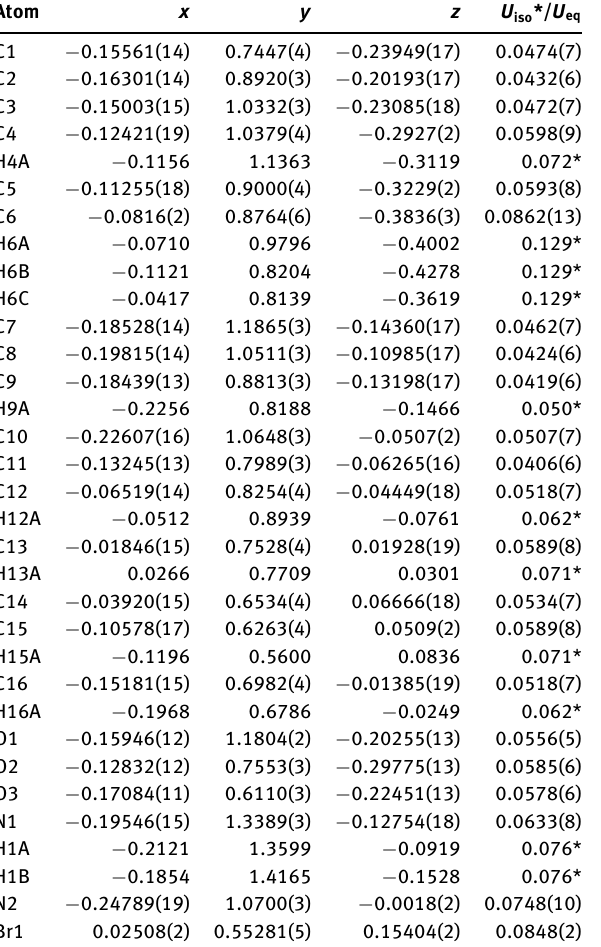
Table 2: Fractional atomic coordinates and isotropic or equivalent isotropic displacement parameters (Å 2 ).